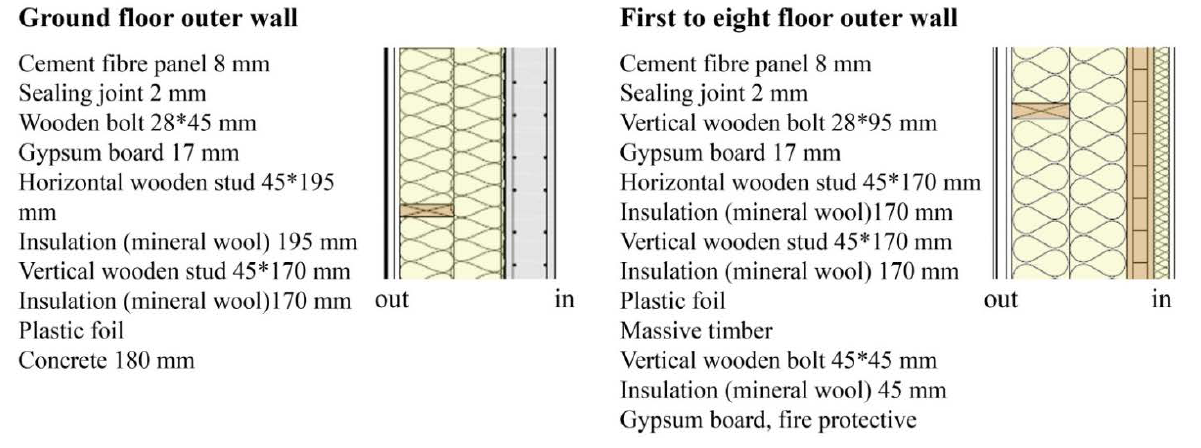
Figure 1. Cross section of the outer wall elements, with concrete-bearing wall at the ground floor and the timber-bearing wall at all upper floors.